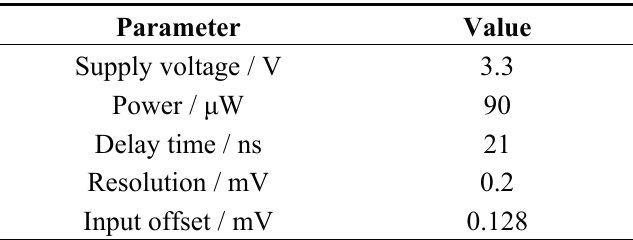
Table 1. Simulation results of the